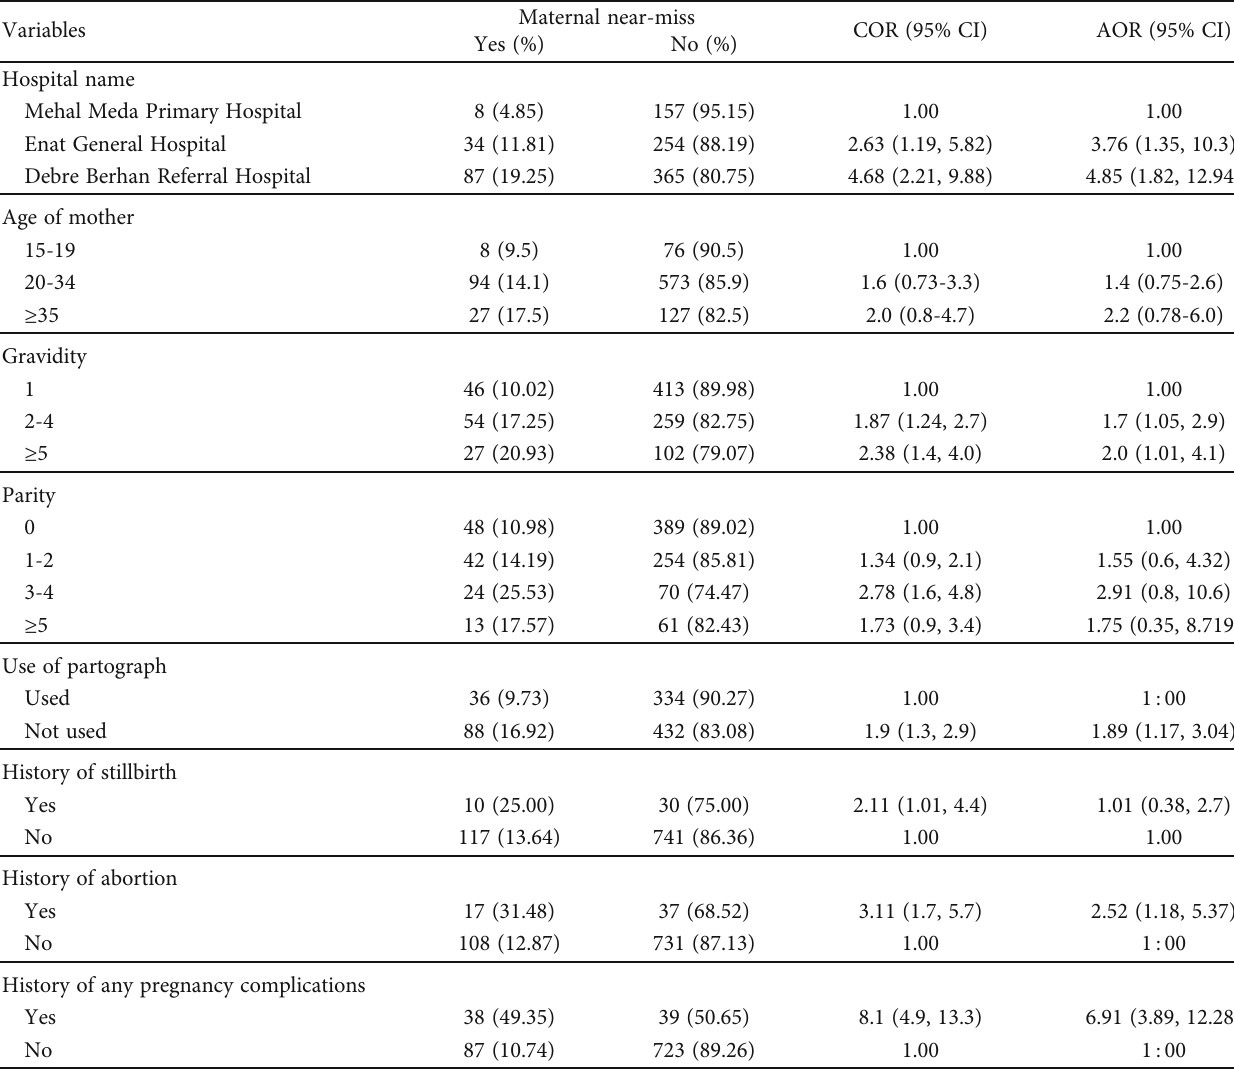
Table 2: Factors associated with the occurrence of the maternal near-miss case among mothers delivered in selected Hospitals of North Shewa Zone, Central Ethiopia